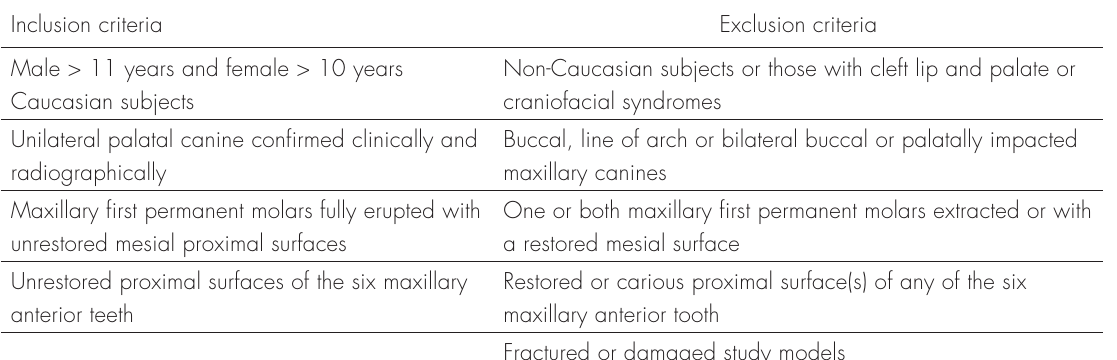
Table I. Inclusion/exclusion